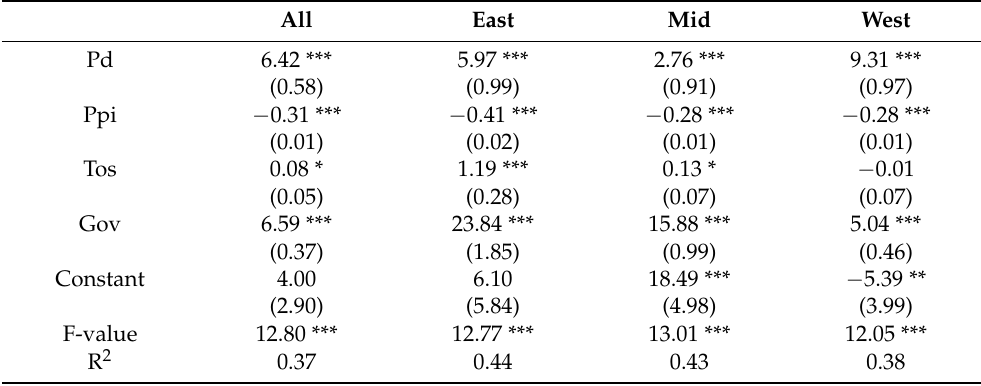
Table 3. Regression results of comprehensive urbanization.